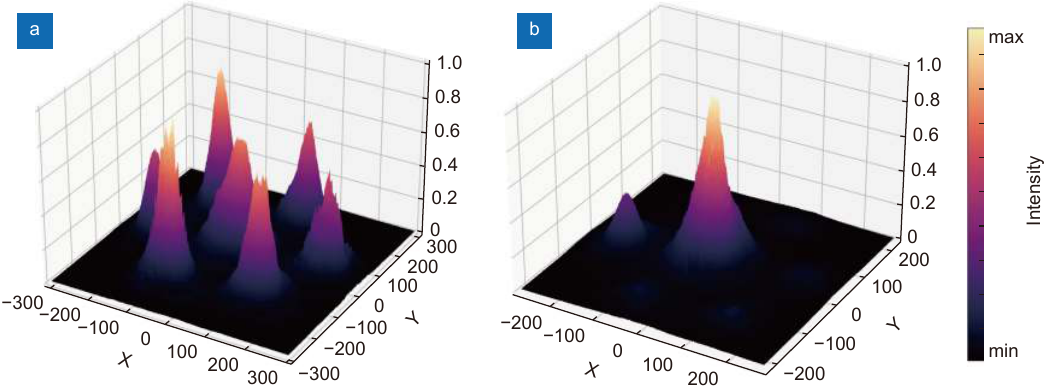
Fig. 15 | The output beams from different cores measured by the beam profiler at a maximum pump power. ( a ) Unabsorbed pump. ( b ) Forward Stokes